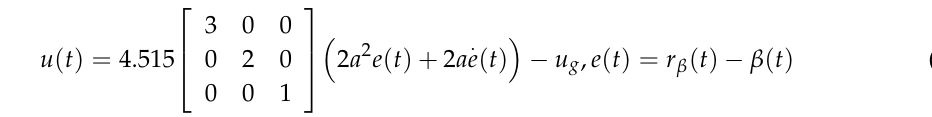
Figure 23. Time histories of the errors using the controller (70) with